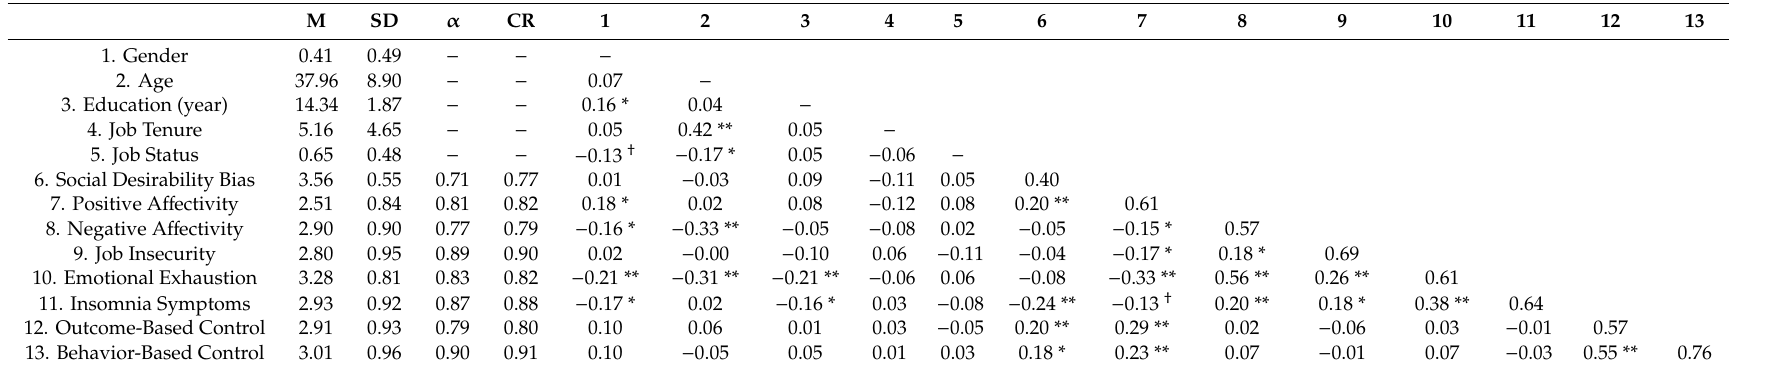
Table 2. Means, standard deviations, and